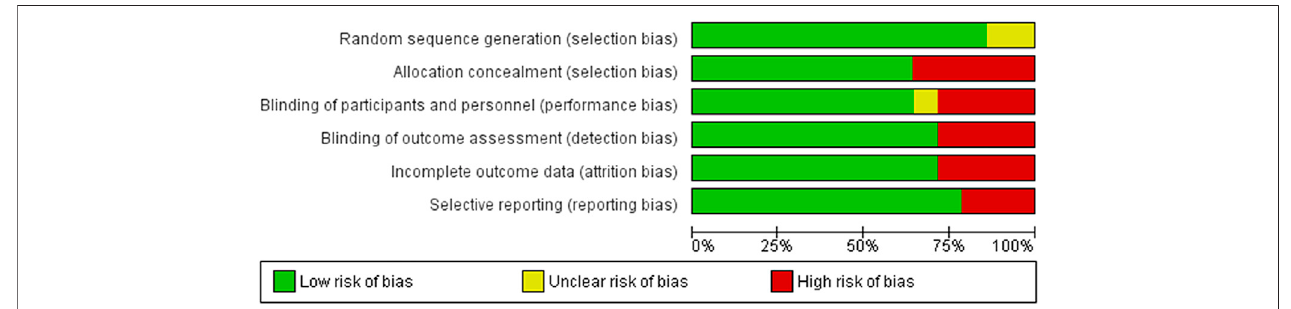
FIGURE 2 | Risk of bias graph presented each risk of bias item as percentages across all included studies.